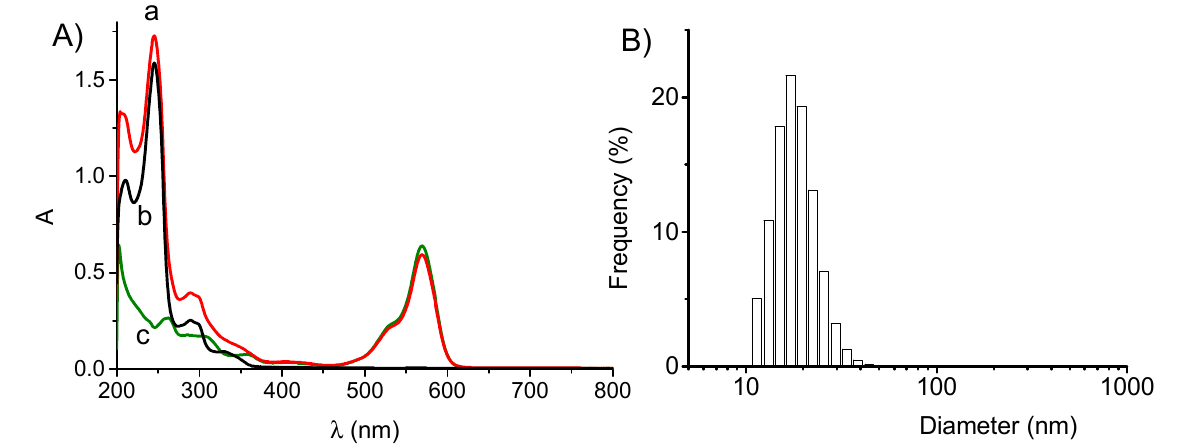
Figure 2. ( A ) Absorption spectra of PolyCD (2 mg mL − 1 ) in PBS (pH 7.4) co-loaded with LVB (25 µ M) and RD-NO (6 µ M) (a) and, for the sake of comparison, loaded only with LVB (b) and RD-NO (c). T = 25 ◦ C; cell path = 1 cm. ( B ) Hydrodynamic diameter of sample a in Figure 2A. As shown in Figure 2, LVB absorption falls in the UV spectral region and does not interfere with the typical absorption band of RD-NO in the visible region centered at 570 nm. This spectral condition permits the selective excitation of RD-NO with the highly biocompatible green light. Figure 3A shows the spectral absorption changes observed upon irradiation of the PolyCD/LVB/RD-NO ternary complex at 532 nm. They show the formation of a new absorption at 397 nm and bleaching at 291 nm, accompanied by the presence of a clear isosbestic point at 348 nm, indicative of a clean photochemical reaction.